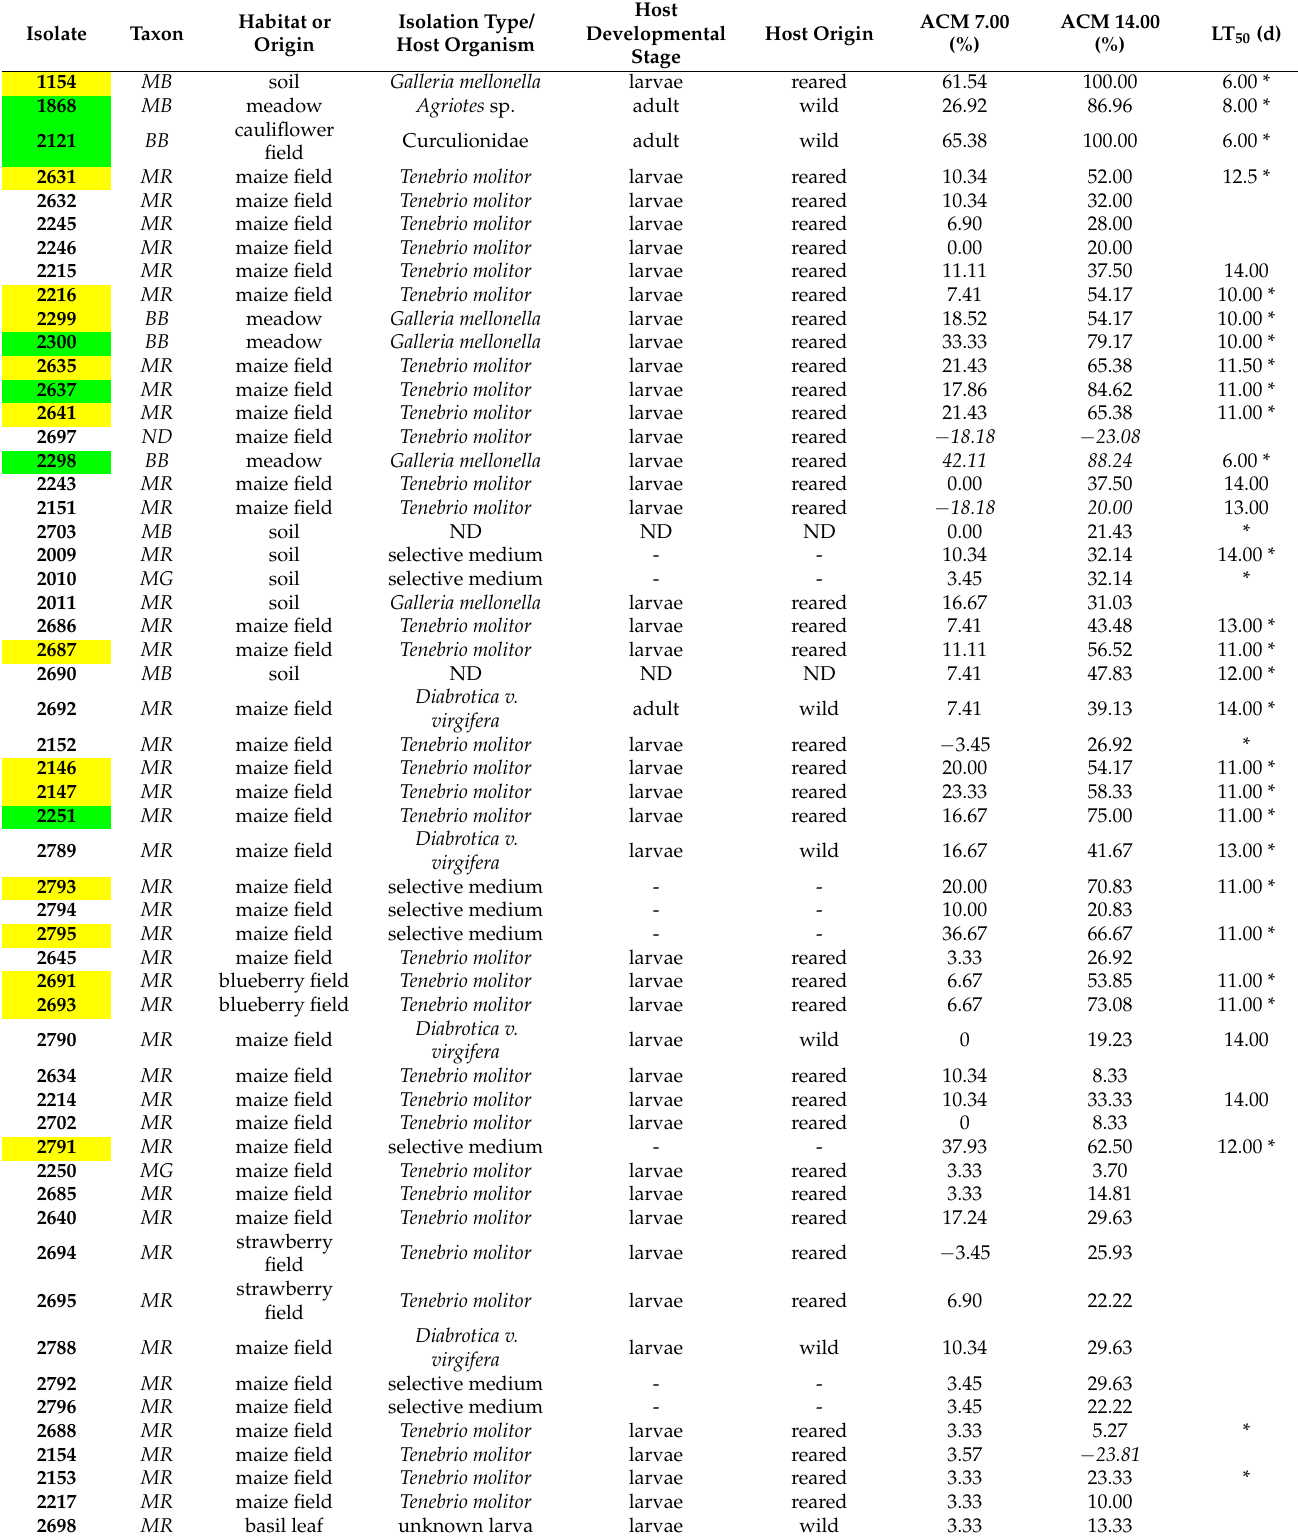
Table 1. Origin and virulence of selected fungal isolates against larvae of Tenebrio molitor . ACM–Abbott’s corrected mortality 7 and 14 days after inoculation; LT50–Median lethal time of T. molitor in days; Green fill indicates most virulent isolates with ACM 14 days after inoculation >75%, yellow fill indicates moderately virulent isolates with ACM 14 days after inoculation between 50% and 75%; * Asterisk indicates significance for survival curve analysis; Italic font indicates unreliable ACM results due to high control mortality (sterile 0.1% Tween